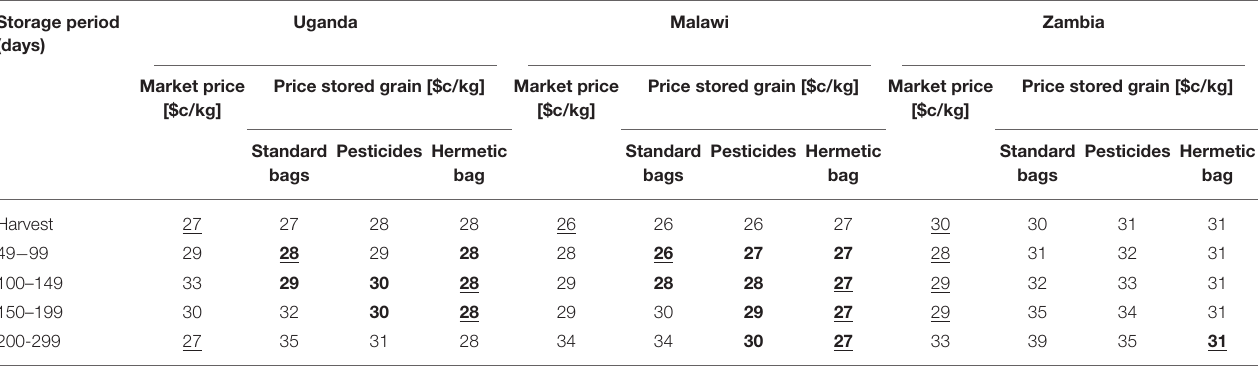
TABLE 5 | Calculated in-house price/kg maize during different types of storage and in different African countries. Storage period (days)